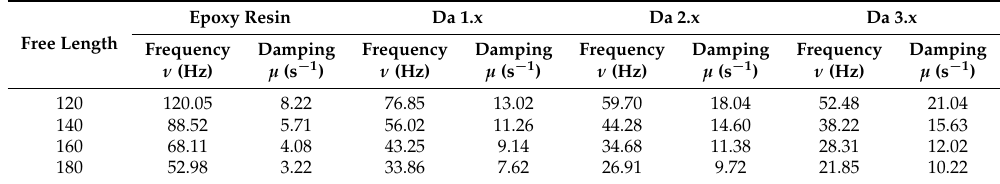
Table 4. The vibration behavior of (epoxy and dammar) resin